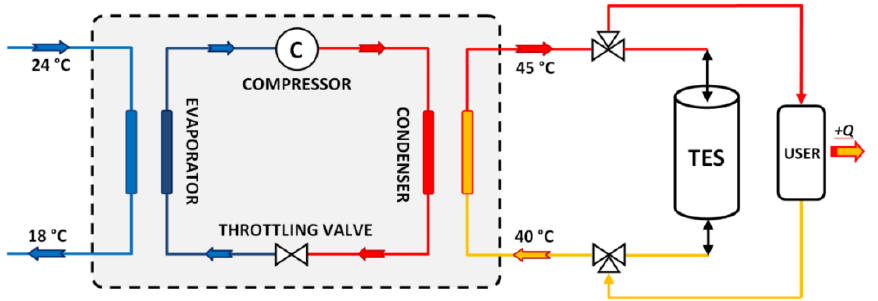
Figure 1. Schematic of the air conditioning system integrated with the thermal energy storage (TES) system.